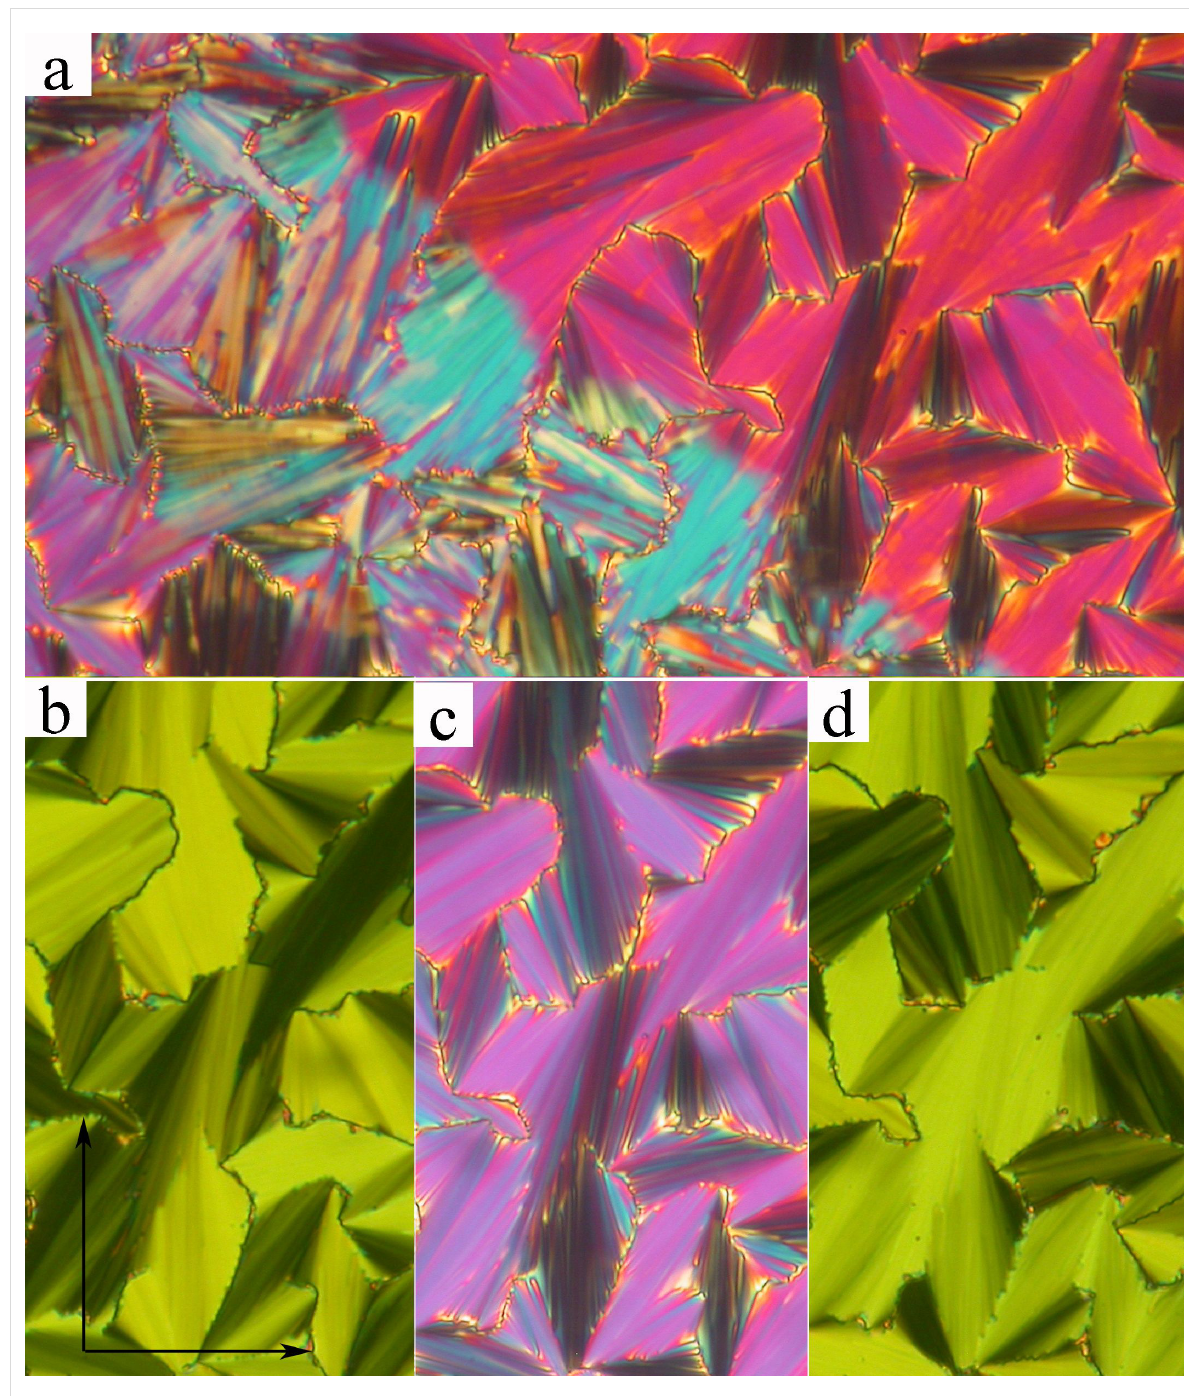
Figure 5: Planar texture of IIb (a) at the phase transition from the SmAP (upper right corner) to the SmC A P A phase (down left corner). Planar texture in the SmC A P A phase at temperature T = 130 °C in the applied electric field (b) E = +20 V/ μ m, (c) without field, and (d) under E = − 20 V/ μ m. The width of the microphotograph is 200 μ m. Arrows mark directions of crossed polarizers in the microscope.